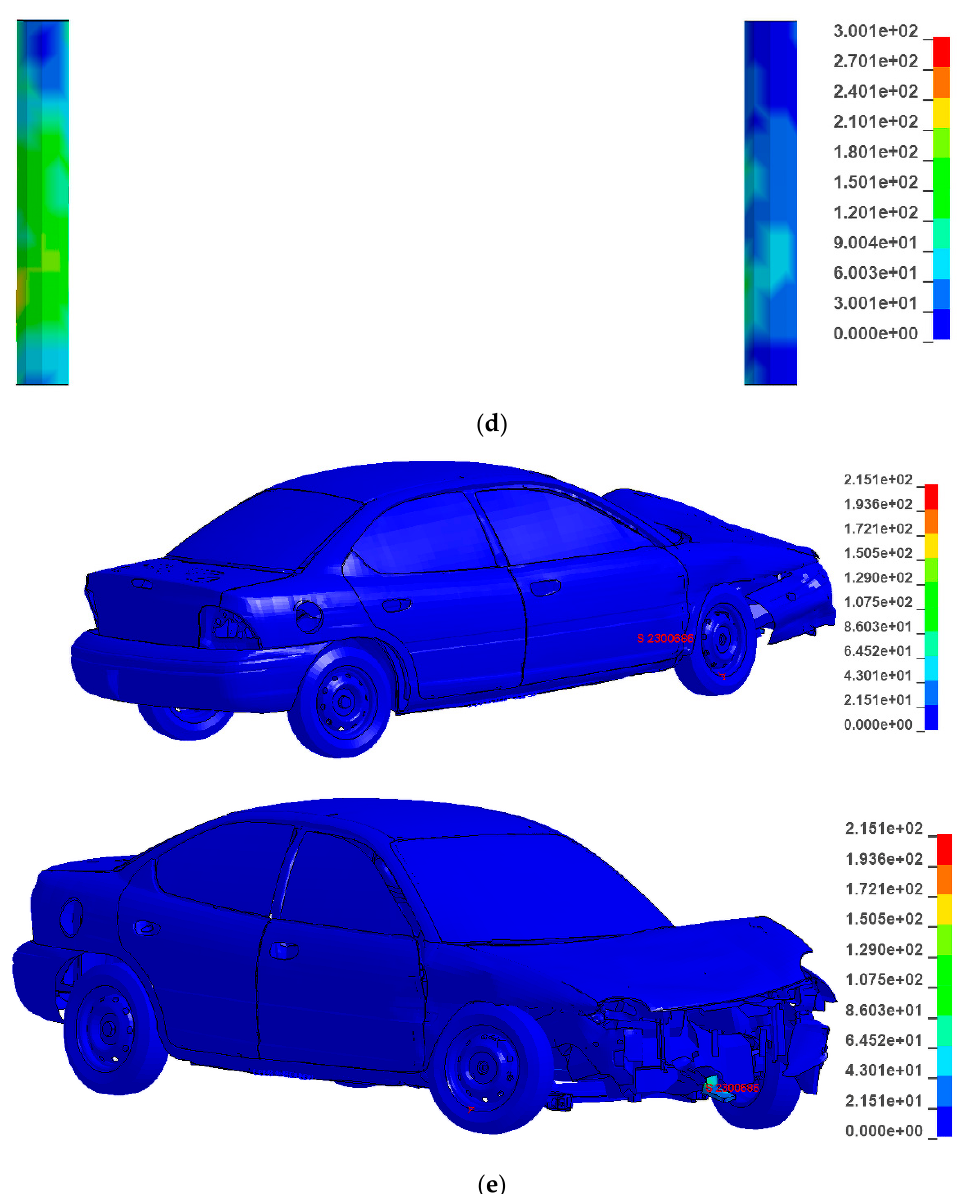
Figure 13. Stress cloud diagram of each main structure of sample N1. ( a ) Stress cloud diagram of the main bridge . ( b ) Stress cloud diagram of the cross section of the guardrail support at the collision point of the main bridge . ( c ) Guardrail stress cloud diagram . ( d ) Stress diagram of guardrail column in the collision area . ( e ) Car stress cloud chart .